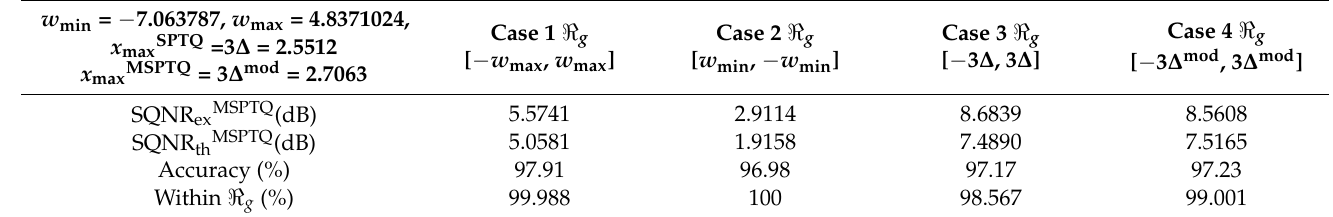
Table 5. SQNR and QNN model’s accuracy for MLP trained on MNIST dataset: the application of MSPTQ designs for bit rate of R = 2